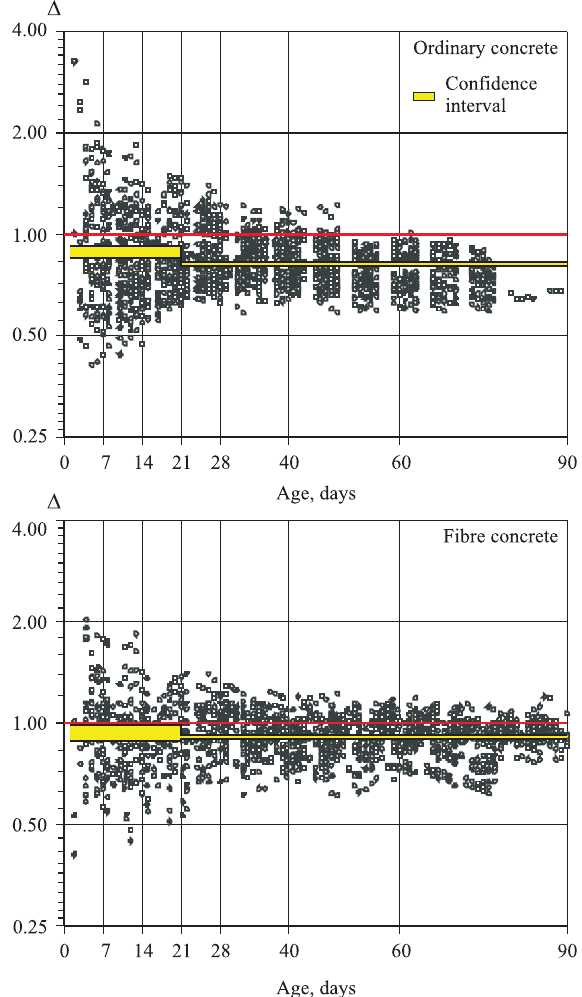
Fig. 6. The shrinkage prediction errors of ordinary and fibre reinforced concretes